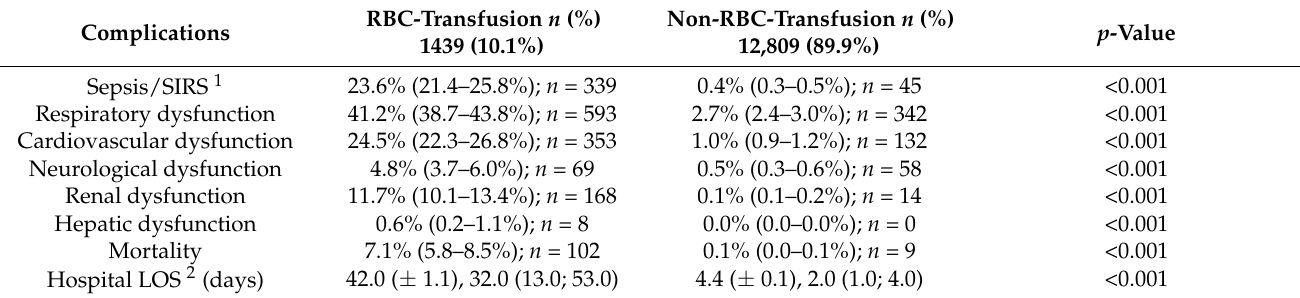
(Table 4). Multivariate analysis demonstrated that sepsis/SIRS ( p < 0.001; OR = 10.16), respiratory ( p < 0.001; OR = 7.56), cardiovascular ( p < 0.001; OR = 4.68), neurological ( p = 0.029; OR = 1.77), and renal dysfunction ( p < 0.001; OR = 16.17) were independent predictors for RBC transfusion (Table 2). RBC transfusion rates were higher in the presence of complications than without: sepsis/SIRS (88.3% vs. 7.9%), respiratory (63.4% vs. 6.4%), cardiovascular (72.8% vs. 7.9%), neurological (54.3% vs. 9.7%), renal (92.3% vs. 9.0%), and hepatic dysfunction (100.0% vs. 10.0%), respectively. Table 4.